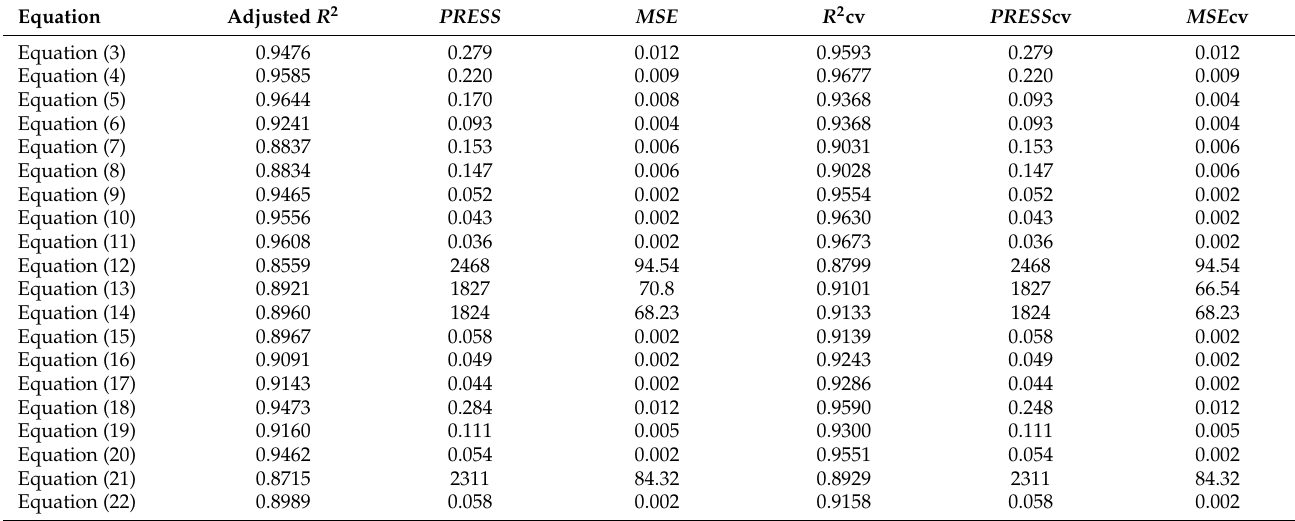
Table 4. Statistical parameters of Equation (3)–(22): PRESS—predicted residual sum of squares, MSE—mean square error, cv—cross